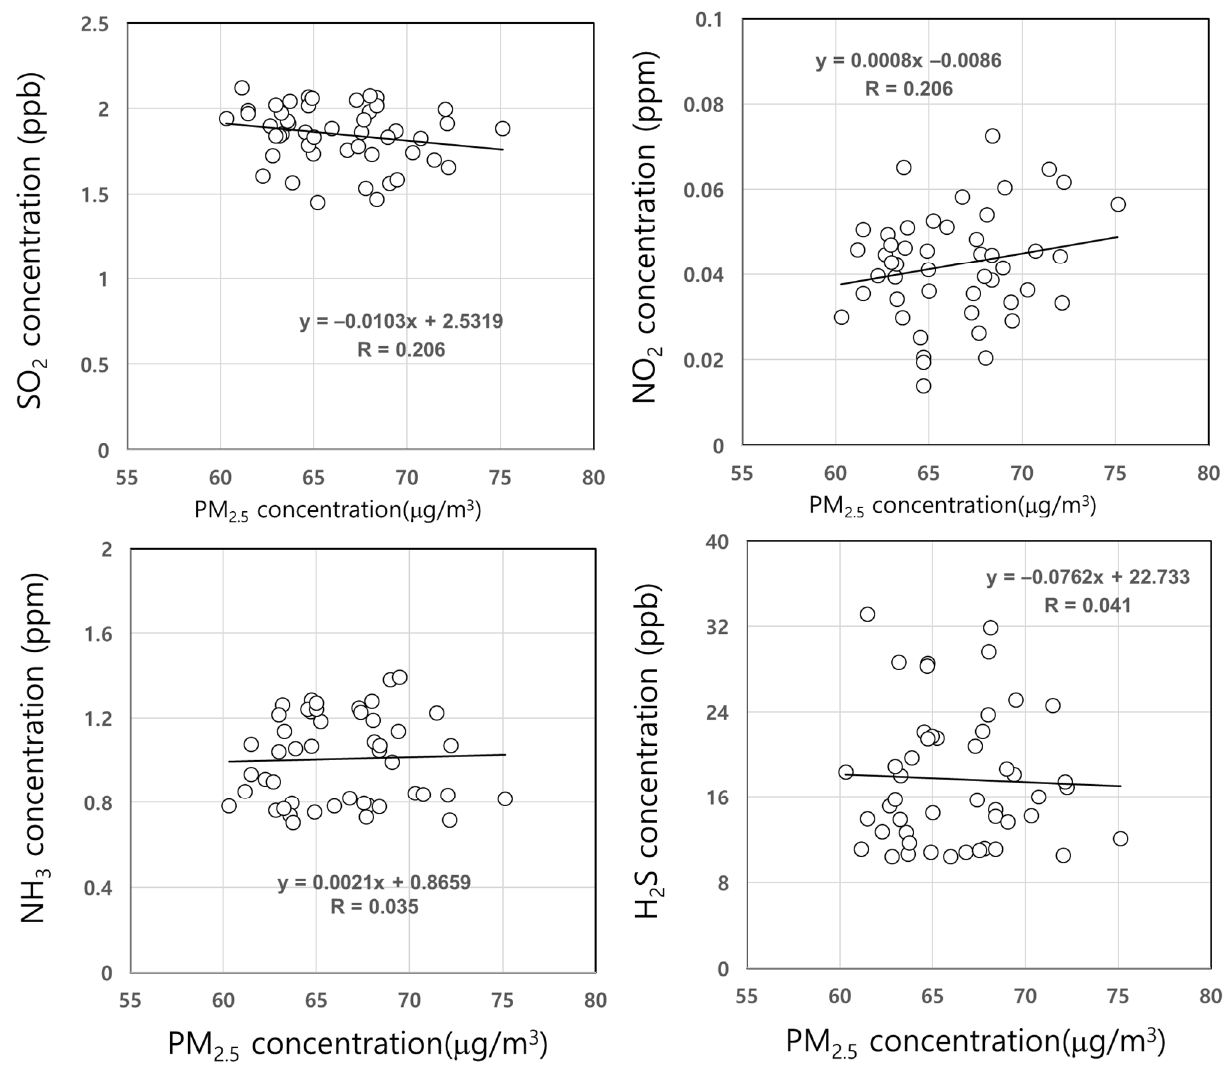
Figure 3. Correlations between PM 2.5 mass concentrations and gaseous concentrations in the barns. ( p ‐ values = 0.160 for SO 2 , 0.161 for NO 2 , 0.814 for NH 3 , and 0.781 for H 2 S, respectively).